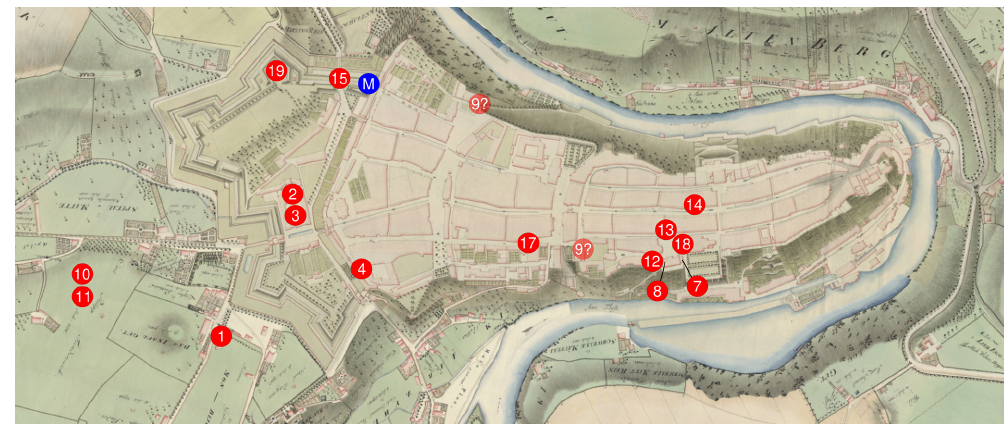
Figure 2. Measurement locations drawn on a historical map of Bern (J. R. Müller, ca. 1797). The numbers refer to Table 1, and the “M” indicates the position of the MeteoSwiss station of Bern–Bollwerk. Map source: Geodaten Stadt Bern, Amt für Geoinformation des Kantons